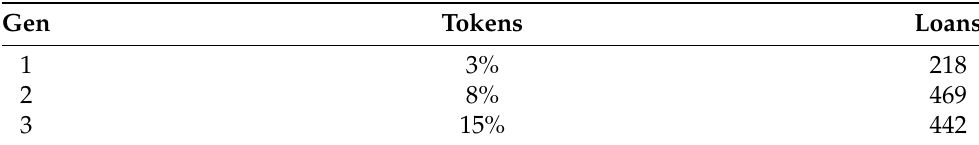
Table 12. Loanword tokens as a percentage of speech data and loanword